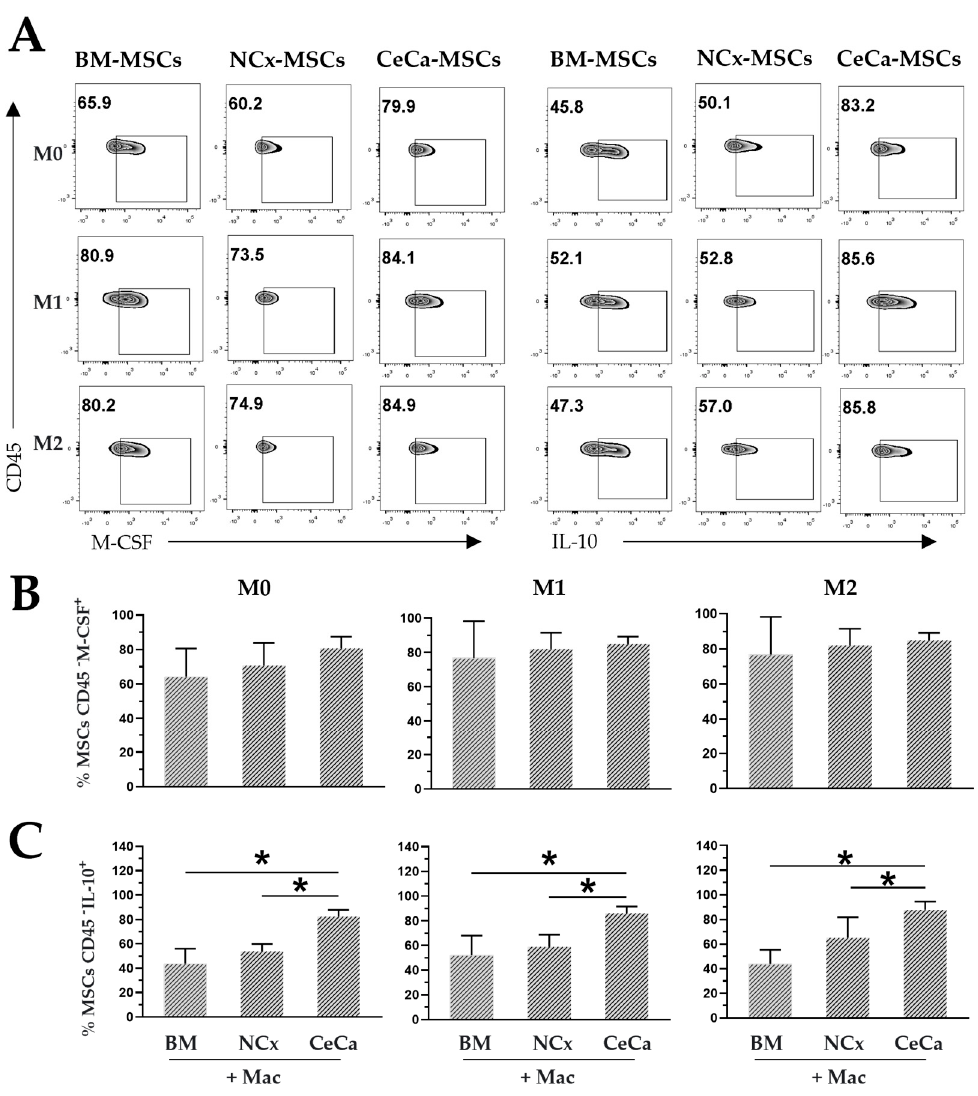
Figure 7. Intracellular expression of M-CSF and IL-10 in CeCa-MSCs cocultured with macrophages. ( A ) Plots representative of the intracellular expression of M-CSF and IL-10 in MSCs from different sources cocultured in the presence of macrophages and M0, M1 or M2 inducing media. ( B ) Percentage of CD45- M-CSF+ MSCs in coculture with macrophages. ( C ) Percentage of CD45- IL-10+ MSCs in coculture with macrophages. Bar graphs represent the mean and standard deviation. * Significant difference ( p < 0.05); n = 6. Mac: macrophages. M0, absence of inducer medium; M1, inducer medium for M1 polarization; M2, inducer medium for M2